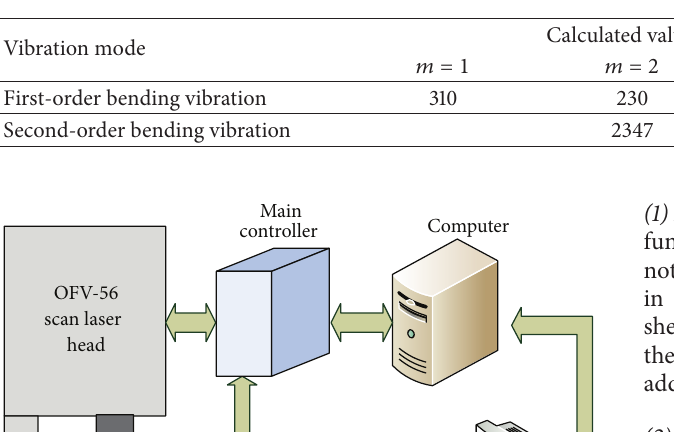
Table 3: Calculated and experimental values of resonant frequency under the driving voltage of 60 V.